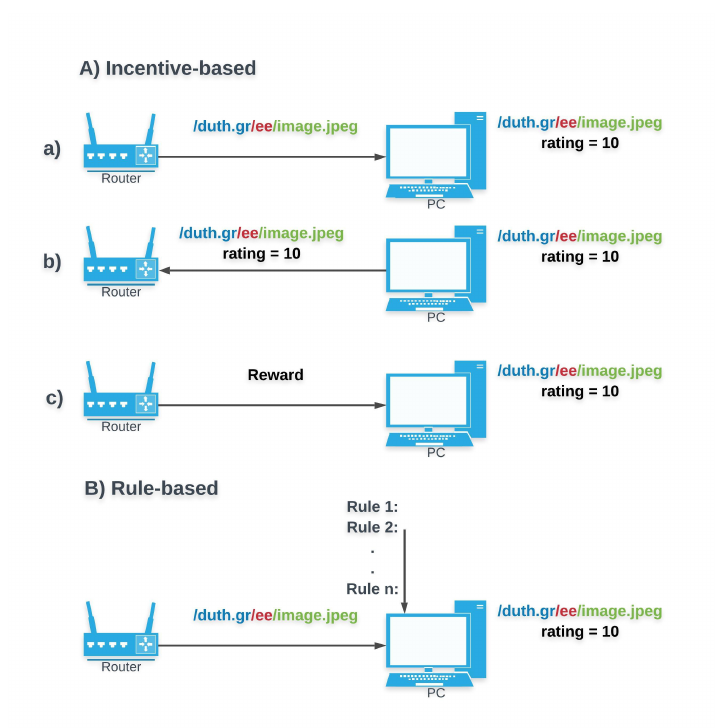
Figure 6. Incentive-based vs Rule-based: ( A )Incentive-based: ( a ) Receiving content & assigning rating, ( b ) Propagating rating to the network, and ( c ) Getting reward, ( B ) Rule-based: Receiving content and assigning rating based on predefined